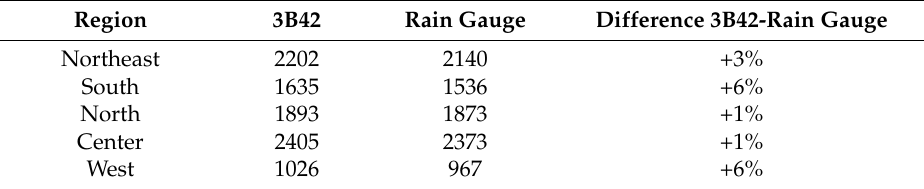
Table 1. Comparison between rain gauge and 3B42 mean annual rainfall (in mm), in each region of the AB. Differences are computed with respect to rain gauge mean. Region 3B42 Rain Gauge Difference 3B42-Rain Gauge Northeast 2202 2140 +3% South 1635 1536 1893